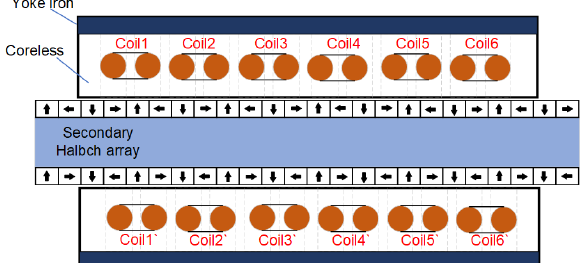
Figure 3. Electromagnetic structure of the electromagnetic actuator.